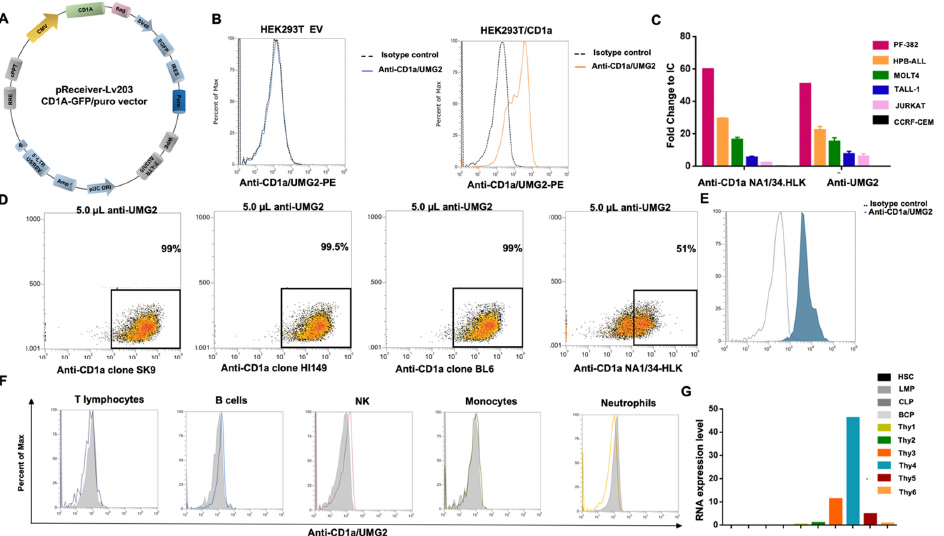
Figure 1. UMG2 mAb binding reactivity. ( A ) Graphical representation of CD1a/GFP vector map. ( B ) UMG2 reactivity on HEK293T cell line transfected with empty vector (left) or CD1a-expressing plasmids (right). ( C ) Reactivity of anti CD1a clone NA1/34-HLK and anti-UMG2 on T-ALL cell lines. ( D ) Competitive binding assay between unconjugated anti-UMG2 and commercially available anti- CD1a fluorochrome-conjugated antibodies (Bl6, SK9, HI14, and NA1/34-HLK) on HPB-ALL cell line. Only NA1/34-HLK anti-CD1a commercial clones partially compete with anti-UMG2. ( E ) Representative FACS data of UMG2 binding reactivity on primary T-ALL cells. ( F ) UMG2 binding on peripheral blood cells from healthy donors. ( G ). CD1a RNA expression level on human bone marrow and thymic progenitor cells.